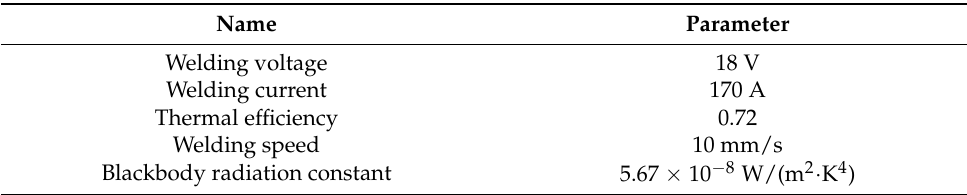
Table 1. Welding simulation